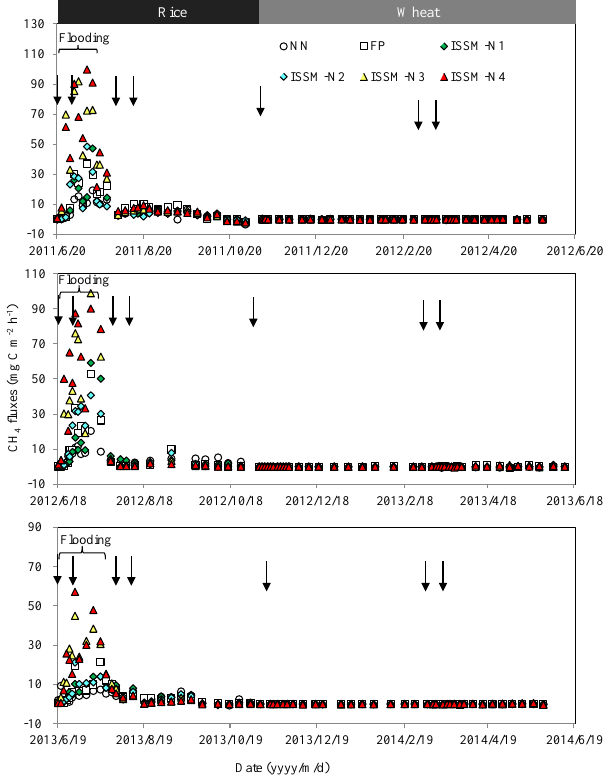
Figure 3. Seasonal variation of methane (CH 4 ) fluxes from the rice- wheat rotation cropping systems from 2011 to 2014. The black and gray part in the figure separates different grain growth periods. See Table 1 for treatment codes. The solid arrows indicate